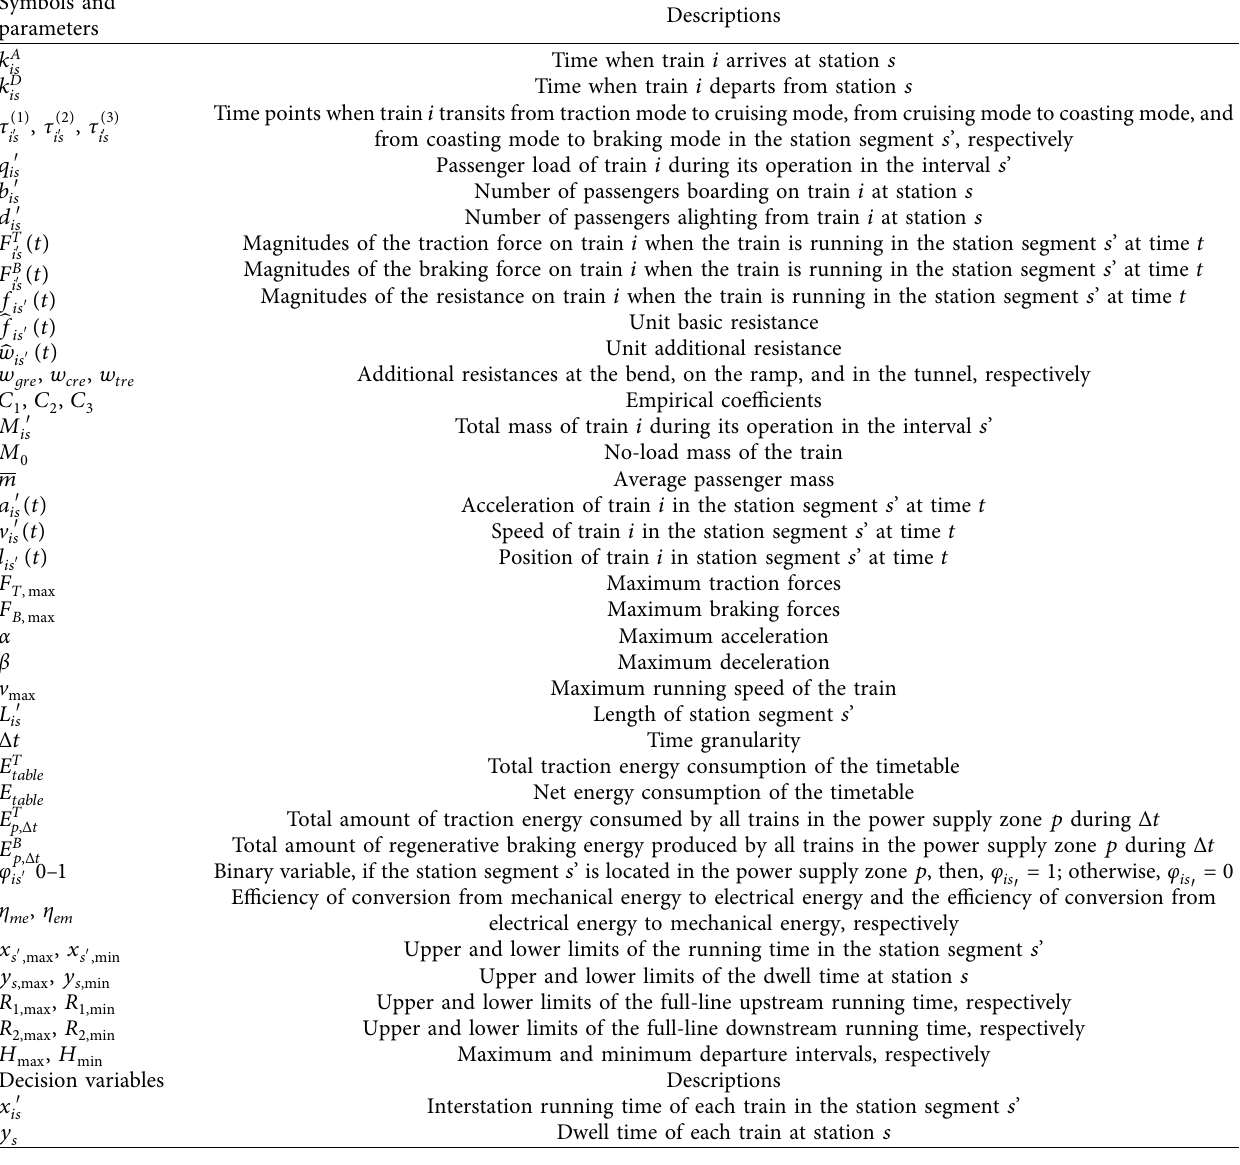
Table 1: Notations of the proposed mathematical